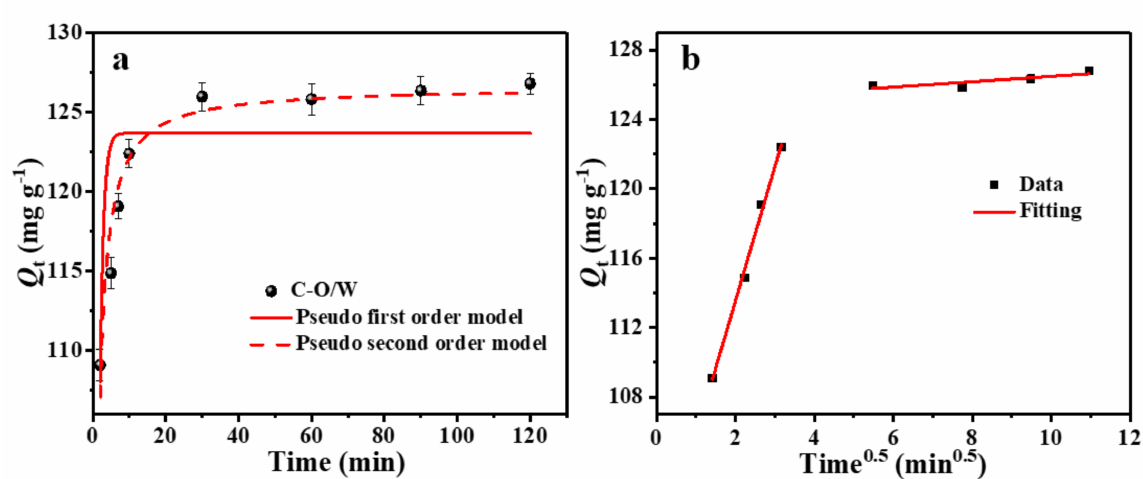
Figure 7. Non-linear kinetic model fitting curve for 3,4,5-TCP adsorption on C–O/W microcapsules ( a ) and particle diffusion ( b ) model fitting curves of 3,4,5-TCP adsorption by C–O/W